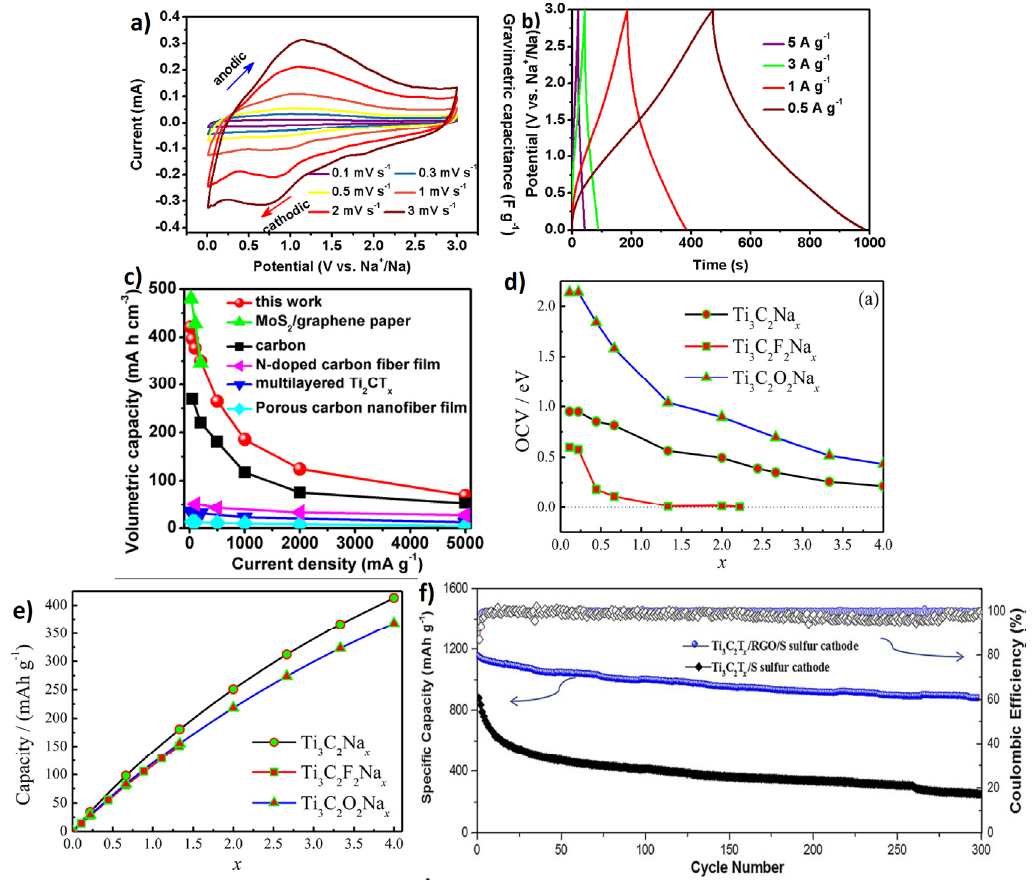
Figure 5. ( a ) Cyclic Voltammetry (CV) plots of the porous Ti 3 C 2 T x /CNT-SA electrode at various scan rates between 0.1 to 3 mV s − 1 , ( b ) galvanostatic charge-discharge profiles at different current densities, ( c ) Volumetric capacities of Ti 3 C 2 T x /CNT-SA, (d) Open-Circuit Voltage (OCV), ( e ) capacity as a function of x in Ti 3 C 2 T 2 Na x with T = bare, F, and O and ( f ) Discharge specific capacity and Coulombic efficiency of Ti 3 C 2 T x /RGO/S composite cathode. Reprinted with permission from [82,84,85].